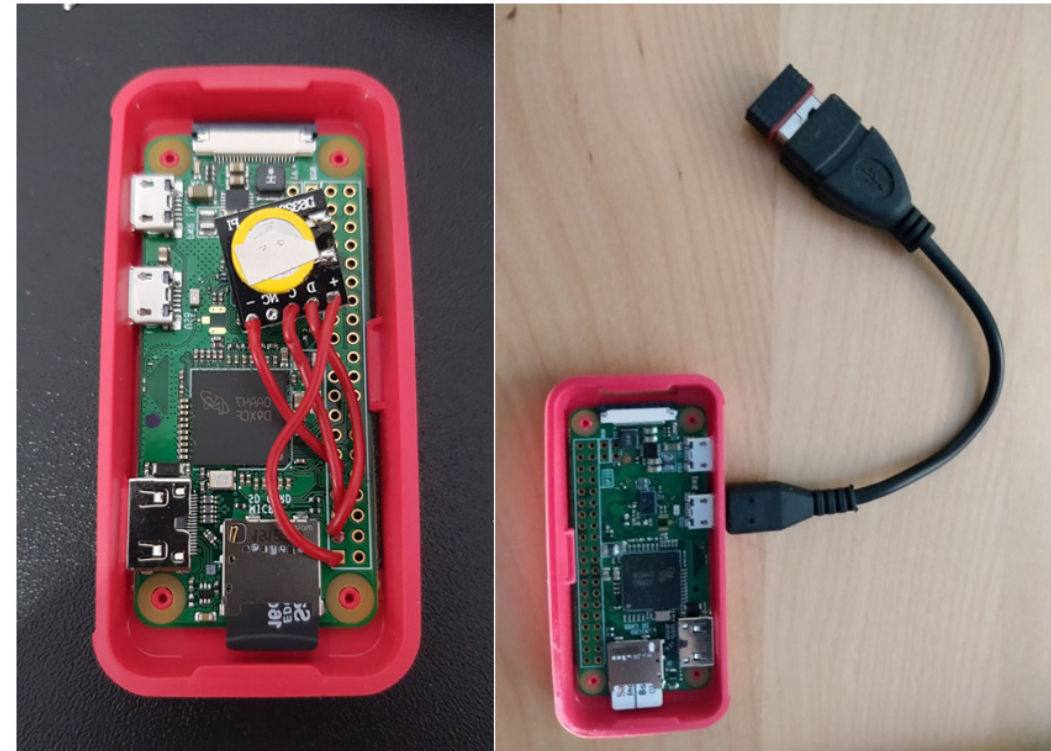
Figure 4. Wi-Fi sensor prototype showing the RTC clock (left) and the external Wi-Fi adapter (right).